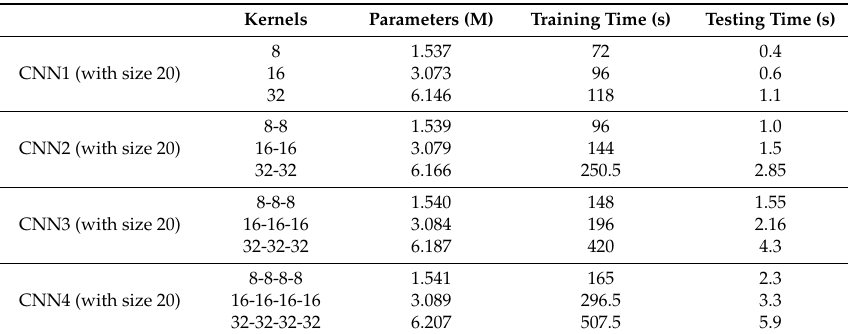
Table 2. Training parameters and computational complexity of CNNs.